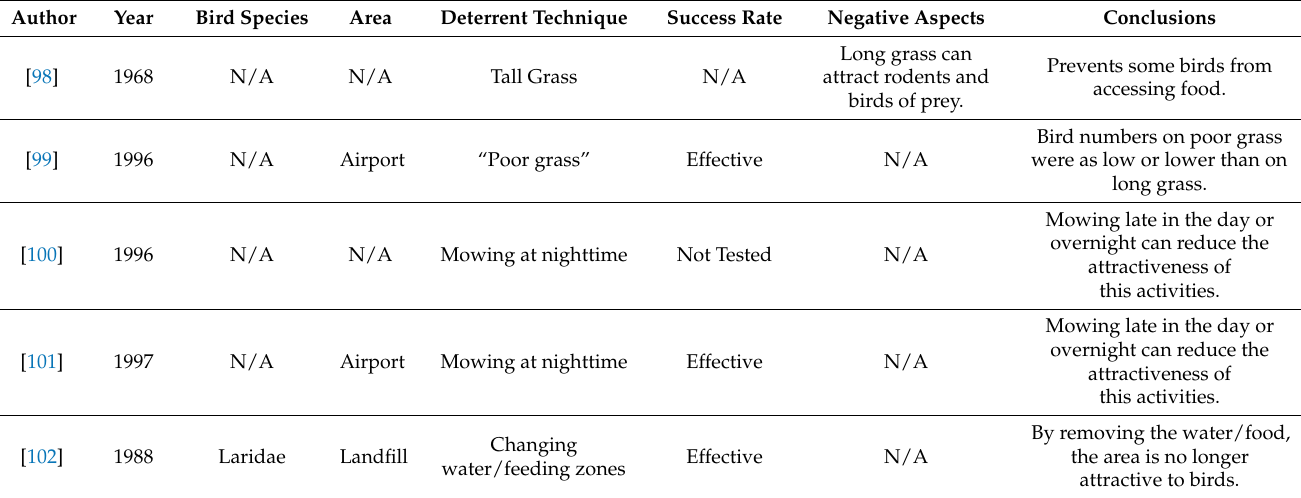
Table 5. Summary of the studies using habitat modification methods.